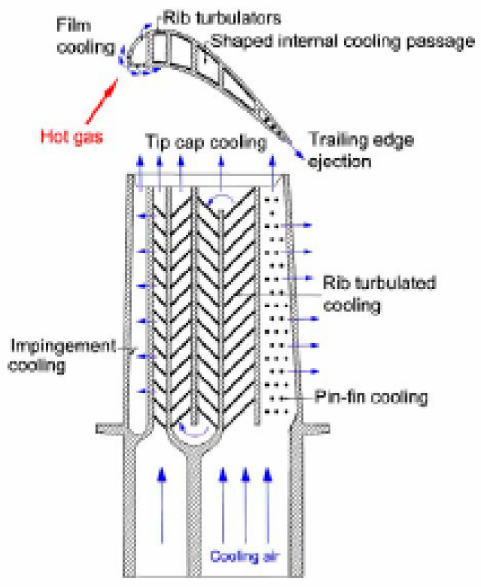
Figure 3. Internal cooling scheme in a typical gas turbine blade